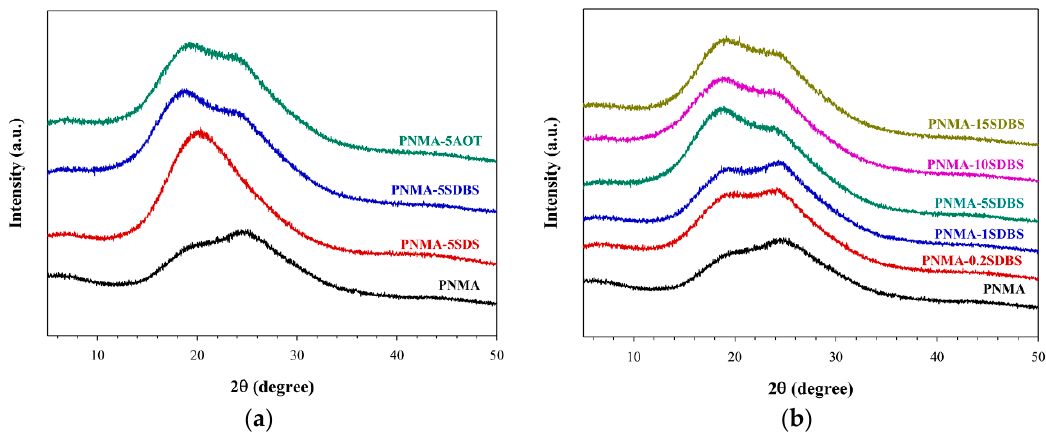
Figure 3. XRD patterns of PNMA synthesized with: ( a ) different anionic surfactants at 5 CMC; and ( b ) SDBS at various concentrations.